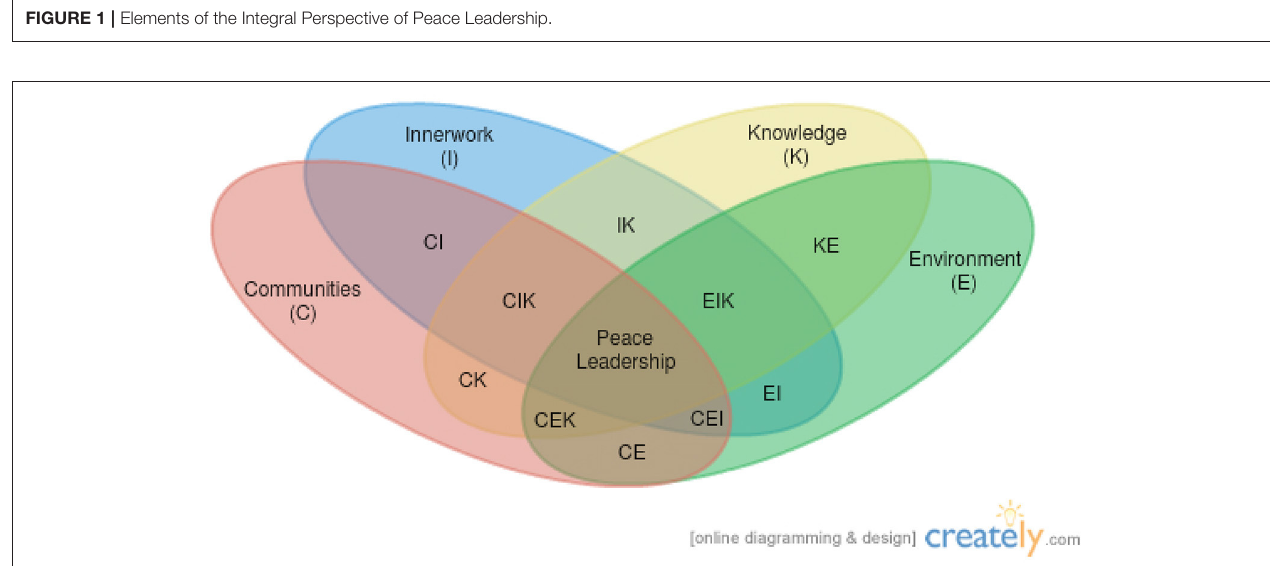
FIGURE 2 | The inter-woven elements of the Integral Perspective of Peace